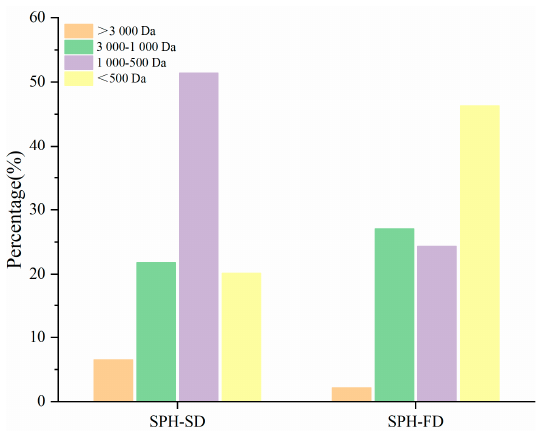
Figure 3. Distribution of MW of SPH-SD and SPH-FD.